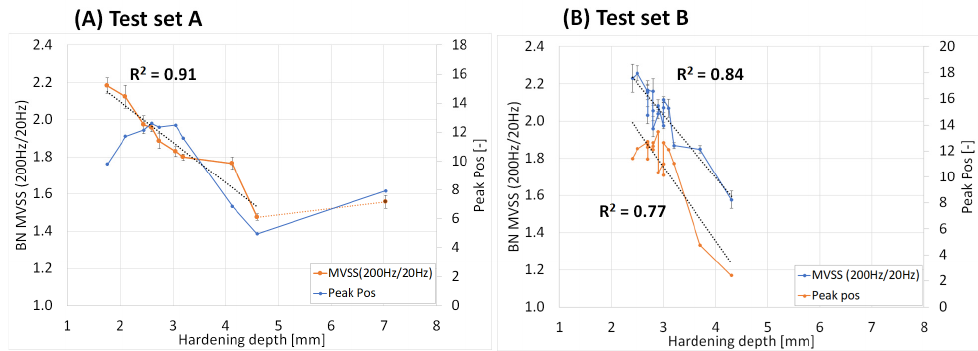
Figure 4. Peak position and MVSS (200Hz/20Hz) versus hardening depth, ( A ) set A and ( B ) set B. The surface residual stresses and diffraction peak broadening, also known as full width half maximum (FWHM), were measured with XRD for the samples as shown in Figure 5. These results showed a great variation of stresses for the different samples rang- ing from high compressive stresses for samples with low hardening depth (HD) to tensile stresses for the samples with high HD. The surfaces residual stresses showed a linear cor- relation to HD for set A, as shown by the high R 2 values of linear trendlines, if the 7 mm sample was considered as an outlier. The FWHM values ranged in the interval 3–7°, show- ing a decrease with a higher HD. The correlation was s-shaped for set A while set B showed a great variation.